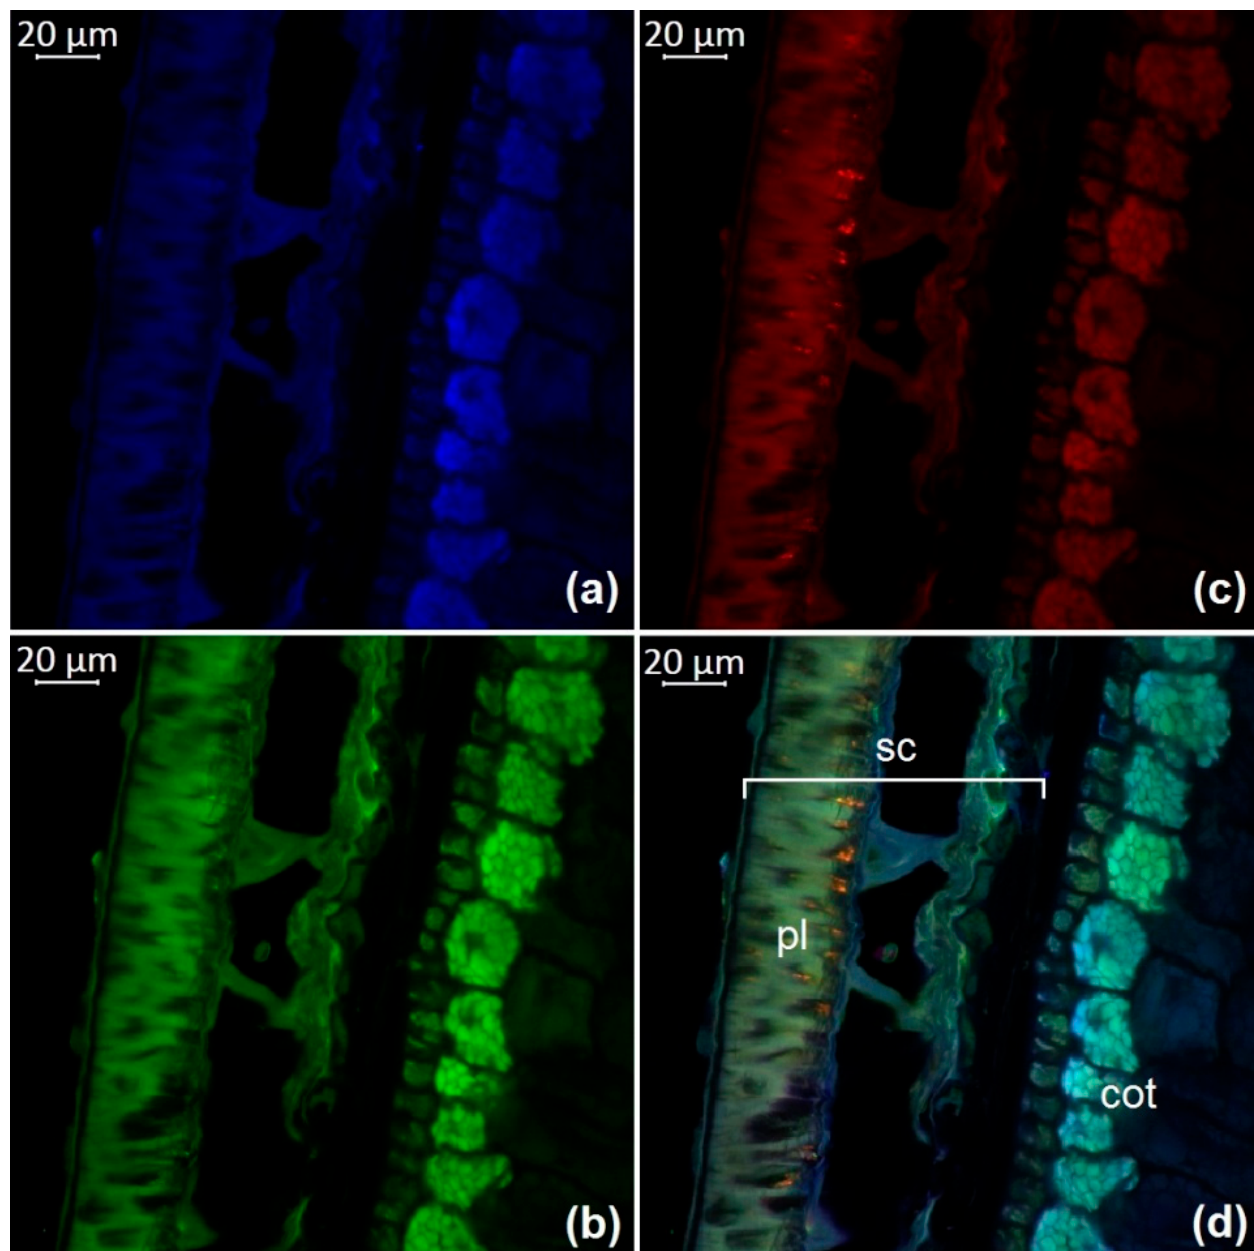
Figure 7. A transverse section of a soybean seed (variety k-5586): ( a ) excitation at 405 nm with emission in the range of 400–475 nm (blue); ( b ) excitation at 488 nm with emission in the range of 500–545 nm (green); ( c ) excitation at 488 nm with emission in the range of 620–700 nm (red); ( d ) merged; cot, cotyledon; pl, palisade layer; sc, seed coat.